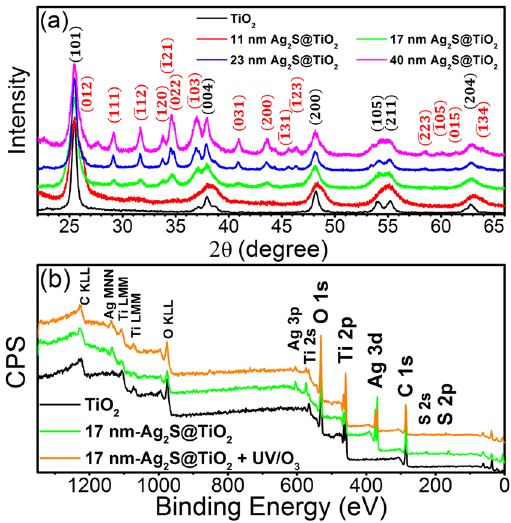
Figure 3. ( a ) XRD scans of pure TiO 2 and Ag 2 S@TiO 2 NFs. ( b ) Full XPS survey scan of pure TiO 2 , 17 nm- Ag